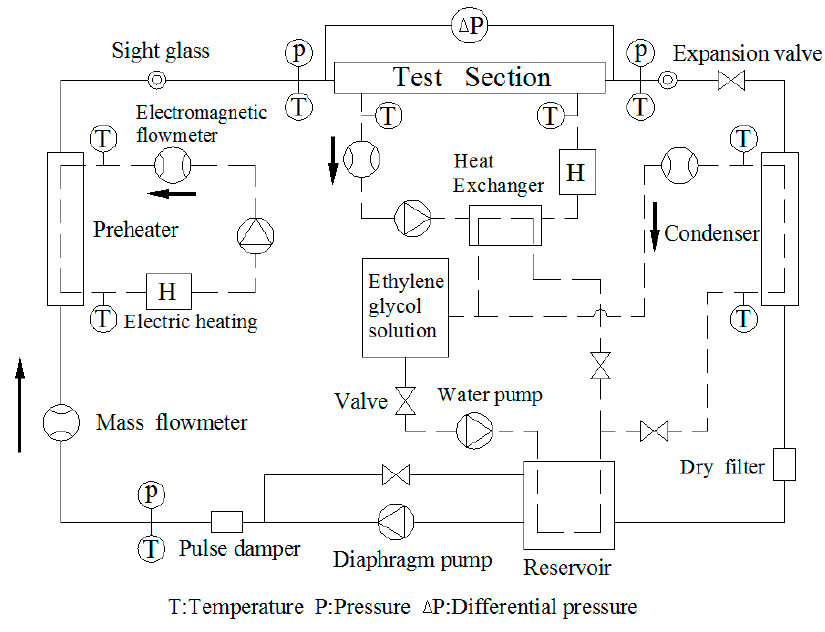
Figure 1. Schematic of the experimental setup.